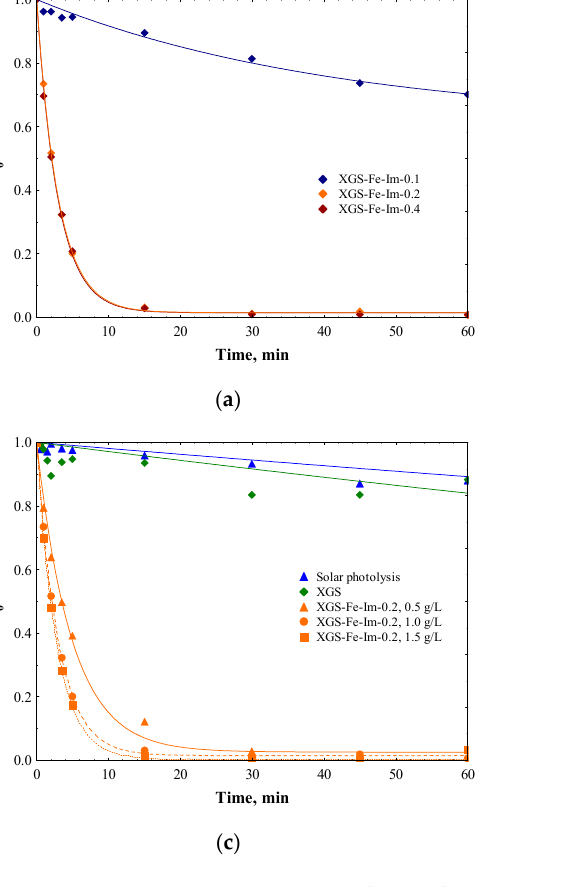
Figure 6. Studies on the XGSs in CPM degradation, in all cases C 0 = 15 ppm: ( a ) effect of impregnation rate during synthesis; ( b ) effect of the particle diameter with XGS-Fe-Im-0.2 material; ( c , d ) effect of the material load for either XGS-Fe-Im-0.2 and 0.4.